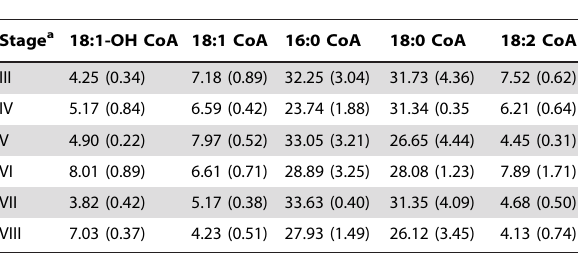
Table 1. Acyl-CoA levels in developing castor